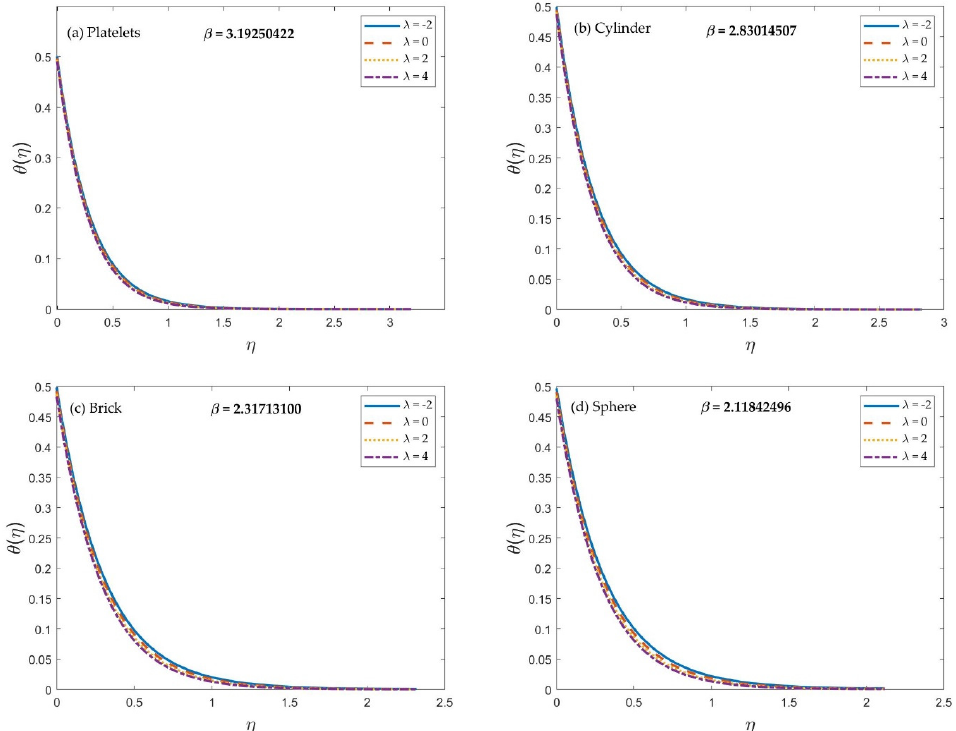
Figure 5. Impact of the mixed convection parameter 𝜆 on the temperature profile for 𝑆 = 0.4 , 𝐾 = 0.5 , 𝜑 = 0.02 , 𝑀 = 1.0 , 𝐵𝑖 = 3.0 , 𝛼 = 𝜋 4⁄ and 𝑃𝑟 = 8.0 .